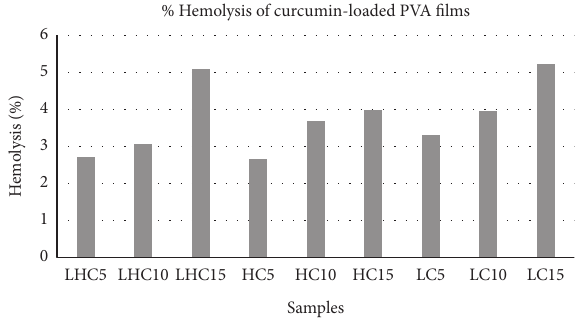
Figure 19: Hemolysis release % of curcumin-loaded PVA films.